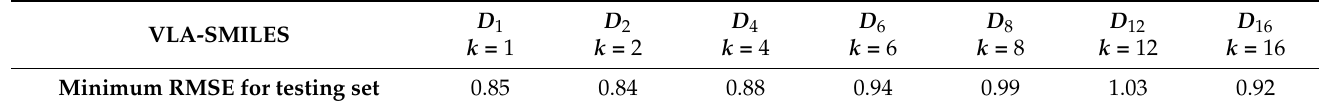
Table 5. RMSE values for testing sets of deep learning, MLP Autoencoder with three hidden layers, and Adam learning procedure (Kennard–Stone-based train-test split, Sigmoid activation), Dataset#1.